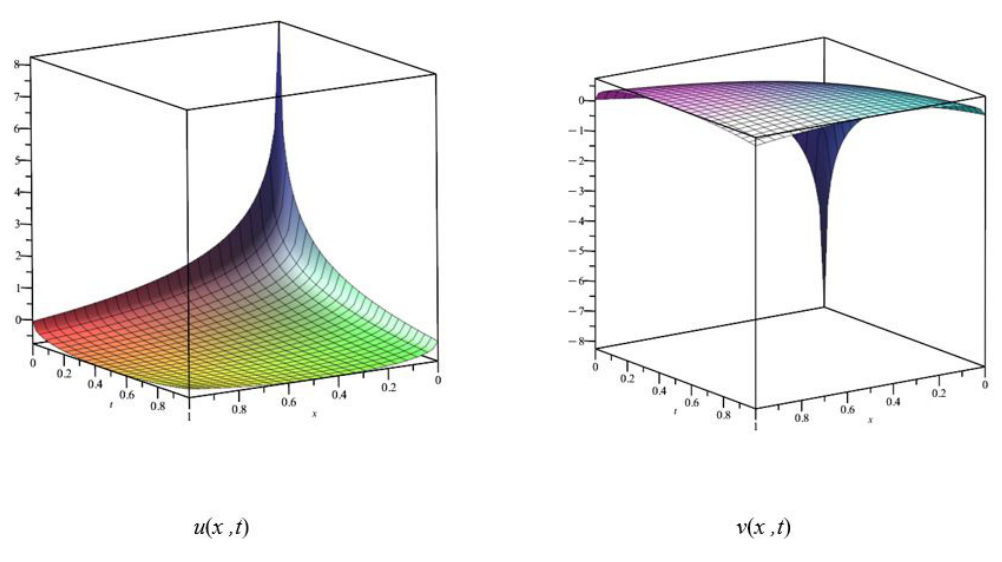
Figure 2. Graphical illustrations of Equations (25) and